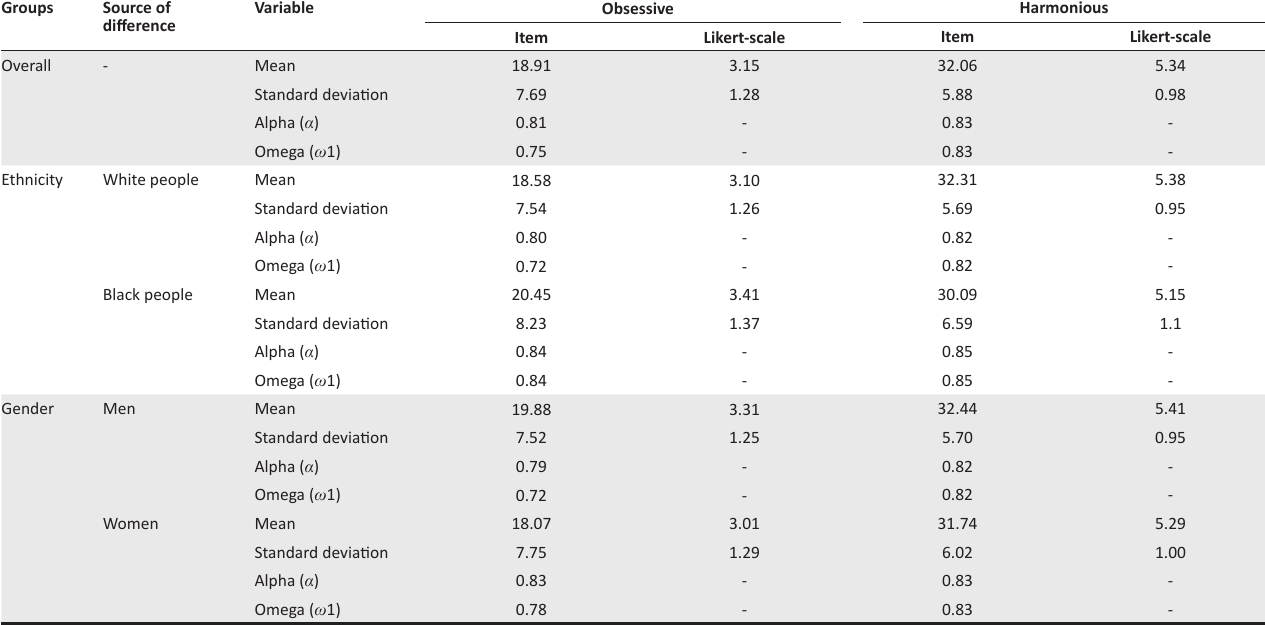
TABLE 5: Passion scale means, standard deviations and reliability coefficients per binary ethnic and gender groups. Groups